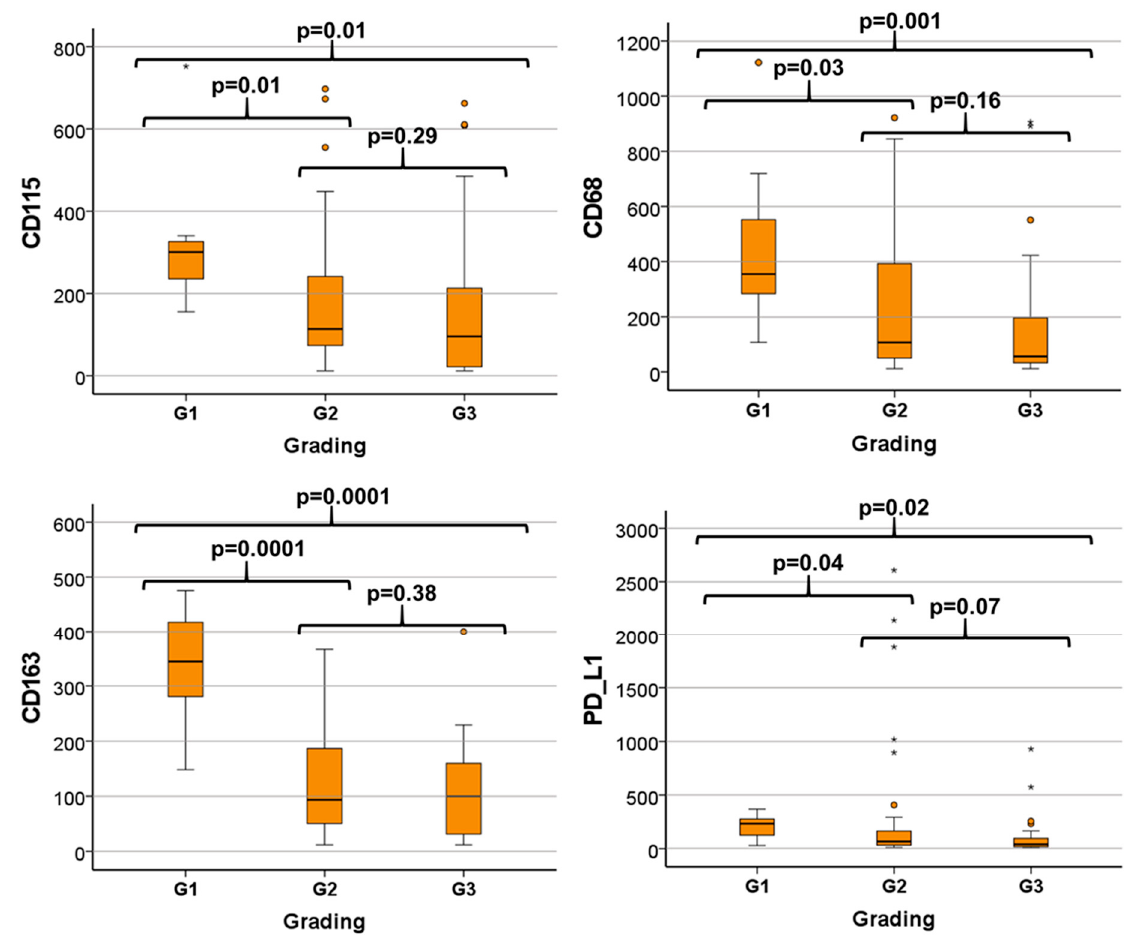
Figure 3. Comparison of expression levels of CD115, CD68, CD163 and PD-L1 between groups of different degrees of differentiation (G1, G2, G3). With increasing dedifferentiation (higher grading), the expression of immune modulators decreased, with the exception of PD-L1. This difference was significant between differentiated (G1) versus undifferentiated malignant tissues (G2 and G3). Number of cases: G1 = 7, G2 = 54, G3 = 35. ○ = outlier; * = extrem value.